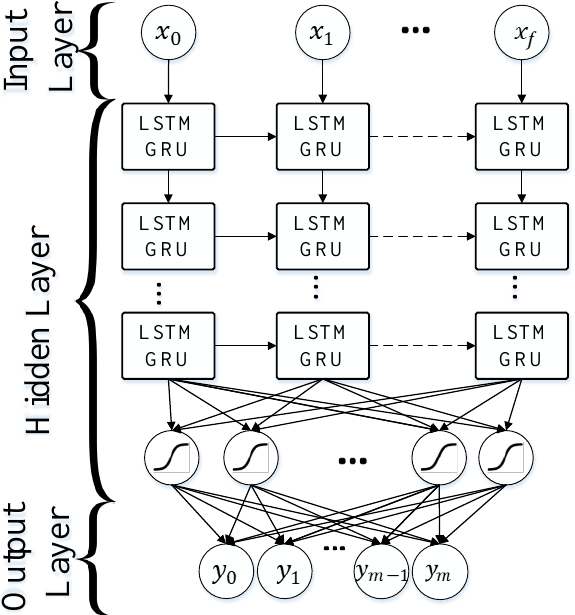
Figure 17. Standard long short-term memory (LSTM)/GRU recurrent neural networks. Long Short-Term Memory